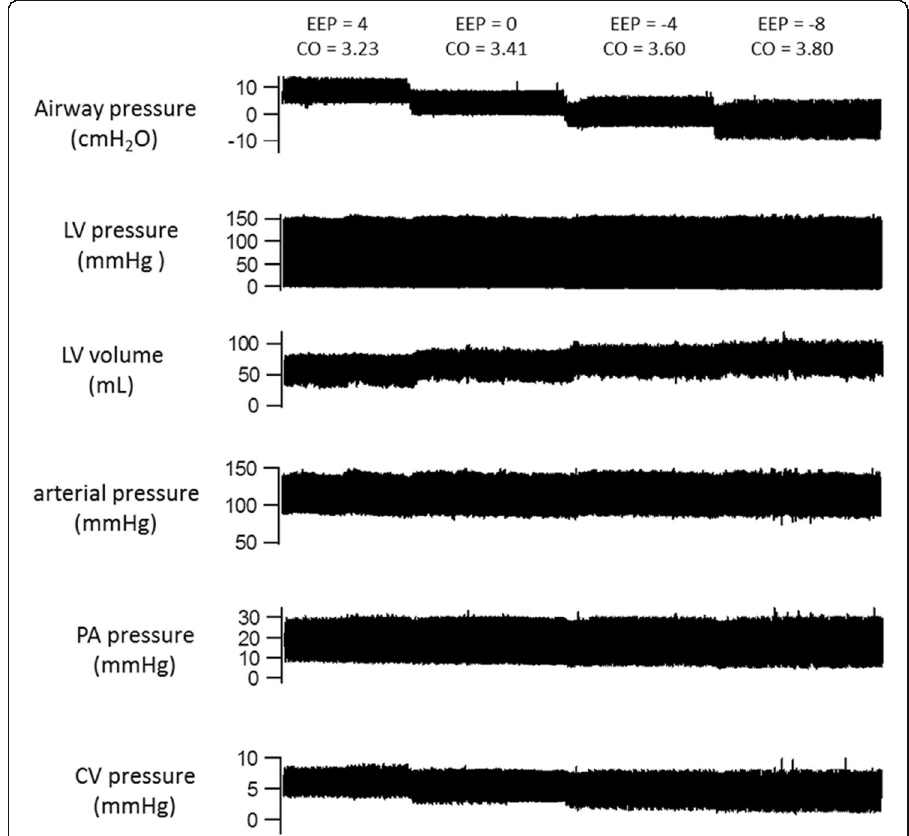
Fig. 2 Hemodynamic variables during expiratory ventilation assistance in a normovolemic subject. The end- expiratory pressure (EEP) is decreased over